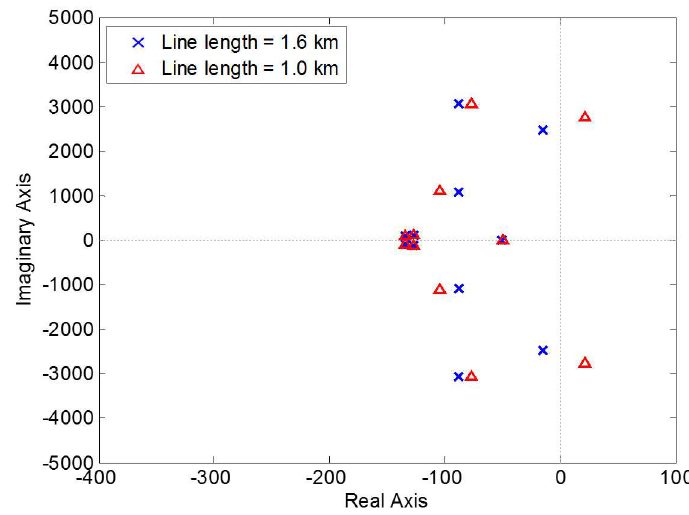
Figure 16. Poles of 1/ ( Y g + Y eq ) when the distance between the converters varies ( K p ,2 = 1.15 and K i ,2 = 50).